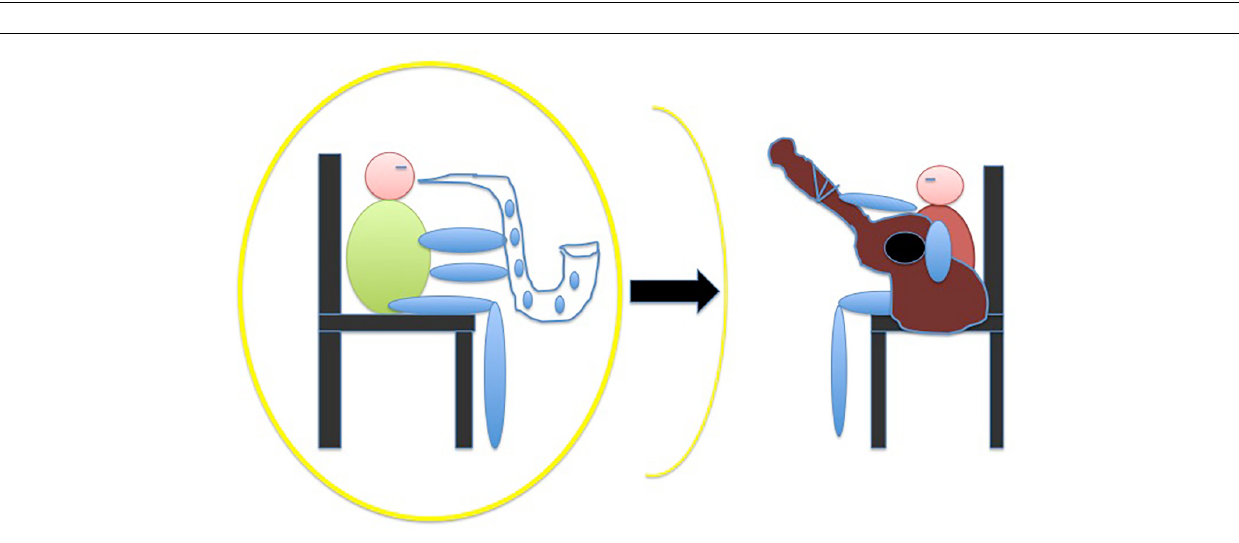
FIGURE 4 | We expected an extension of the musician’s peripersonal space after the cooperative interaction, but we obtained a sort of disappearance of it after the uncooperative interaction. In any case, we may conclude that the joint sense of agency was corrupted by the uncooperative